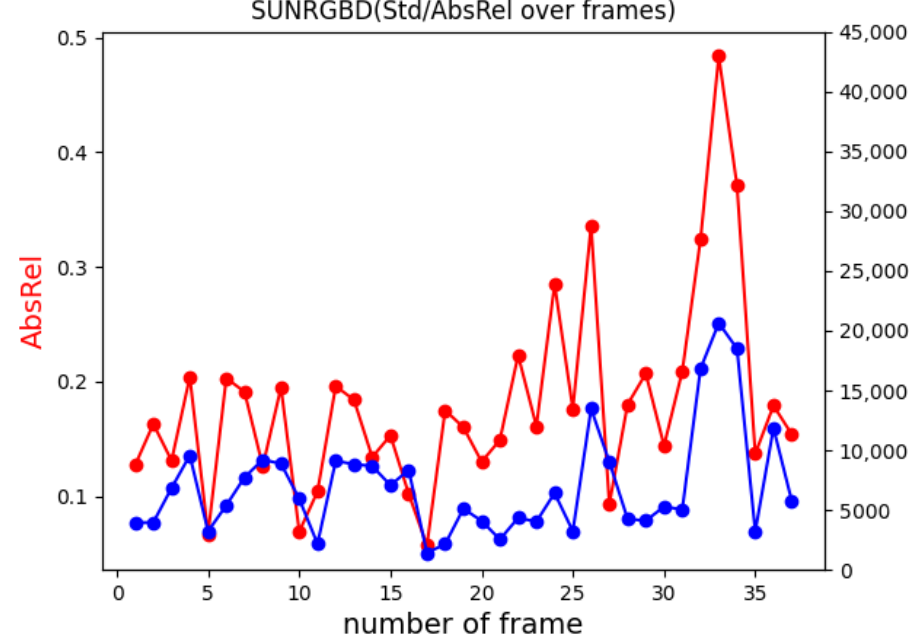
Figure 9. The plot shows in red the absolute relative error (AbsRel) and in blue the standard deviation of depth (Std) for the B3DO sequence from SUN RGB-D